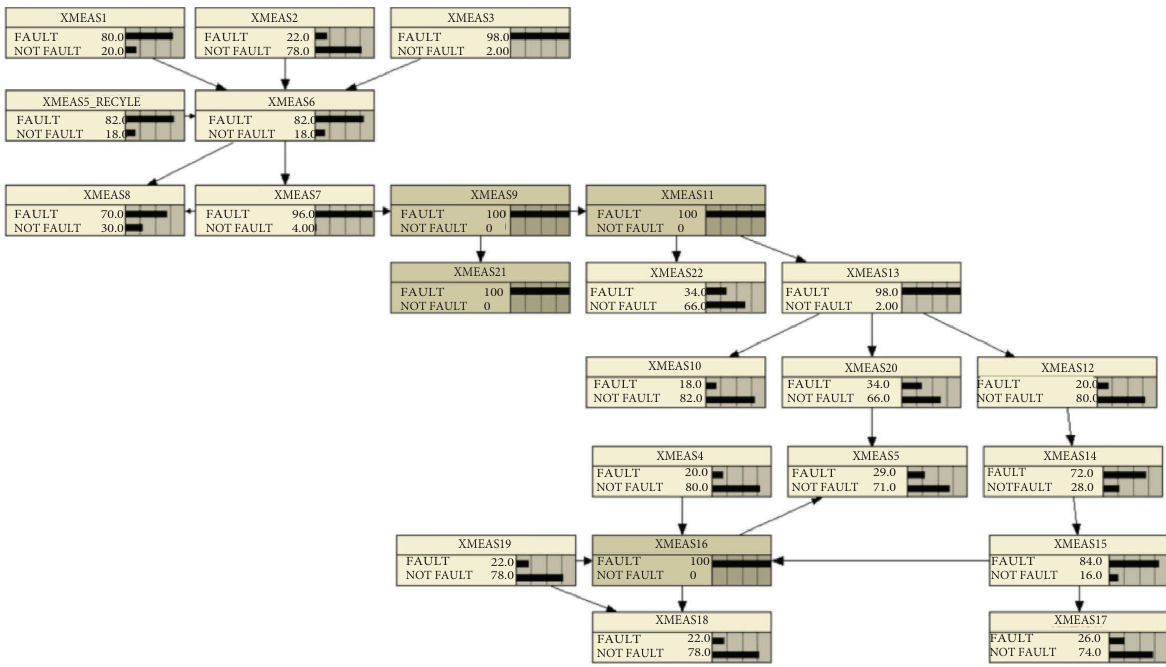
Figure 12: Bayesian network of E feed